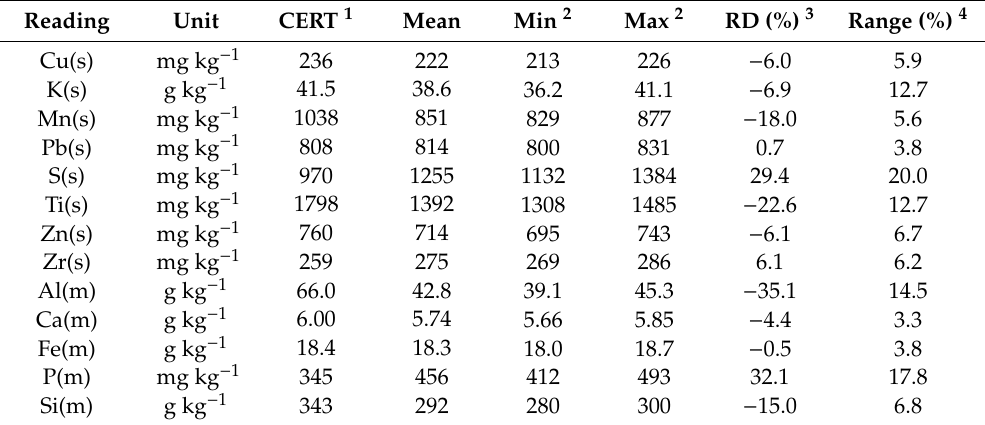
Table 2. Evolution of the readings ( n = 7) of the reference material sediment SdAR-M2 as determined using the mining (m) and soil (s) methods of the portable X-ray fluorescence (pXRF) spectrometer.